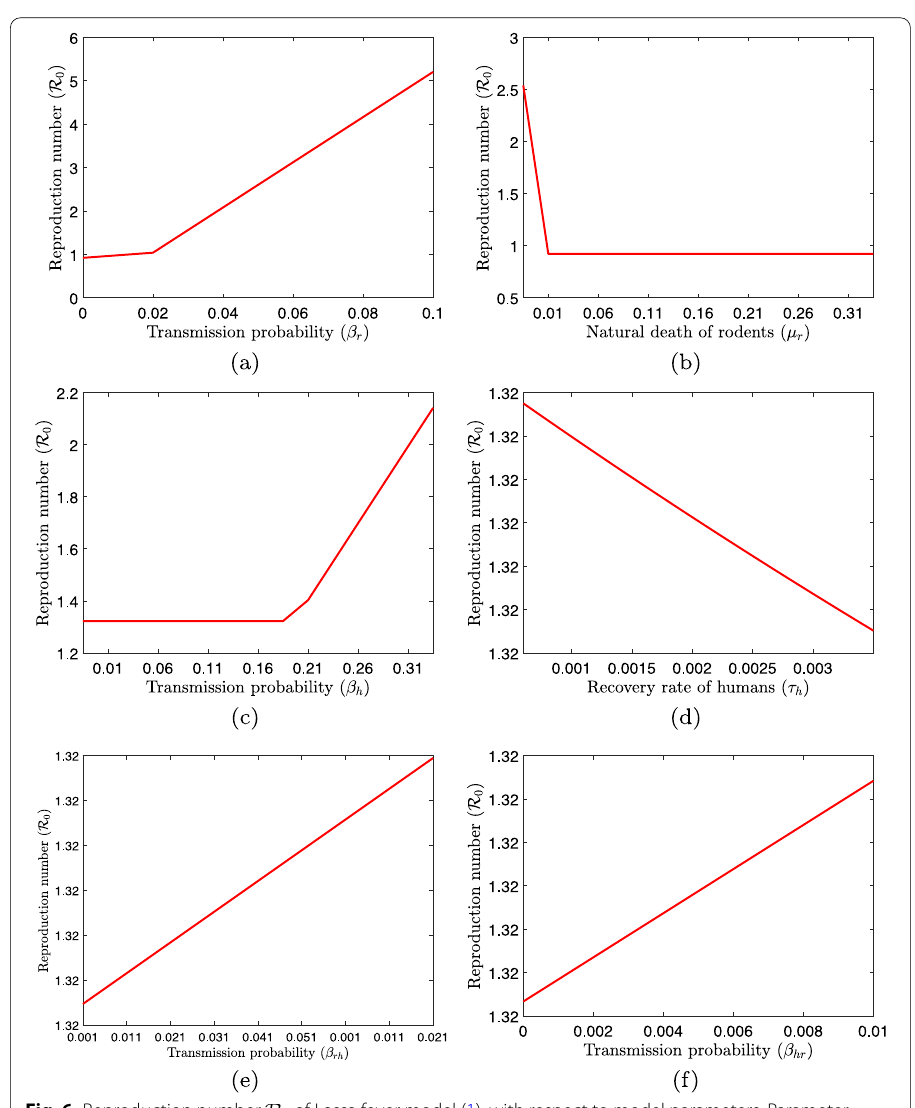
Fig. 6 Reproduction number R 0 of Lassa fever model (1), with respect to model parameters. Parameter values used are as given in Table